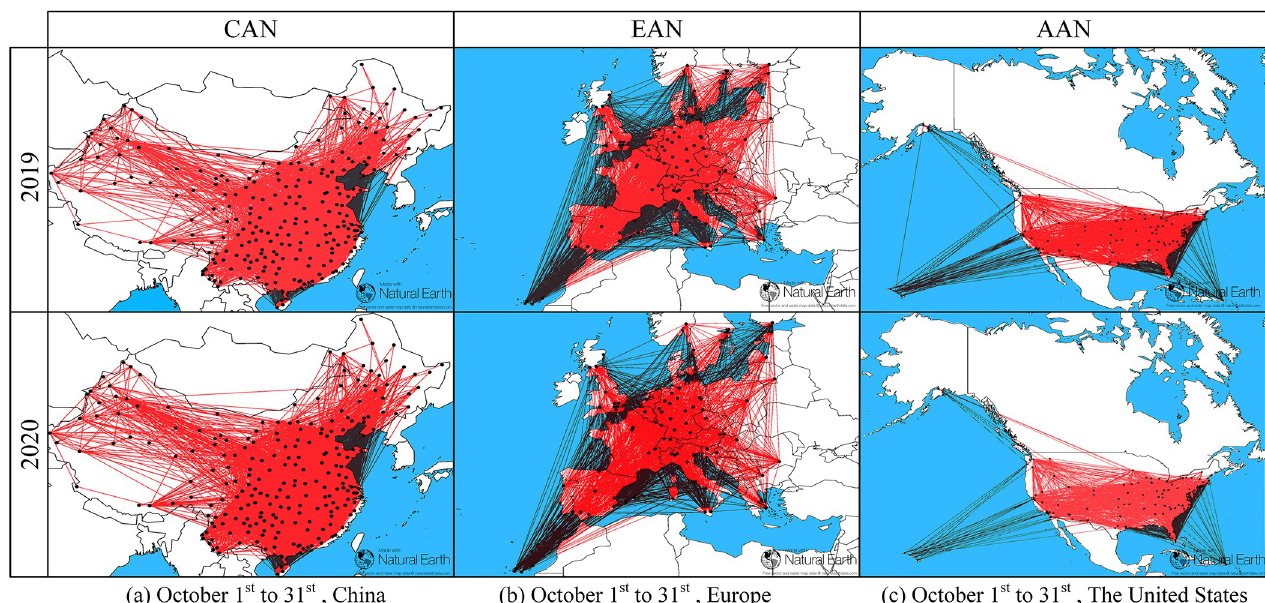
Fig 3. CAN, EAN and AAN weighted airport topologies for the period October 1 to 31 before and during the COVID-19 pandemic.